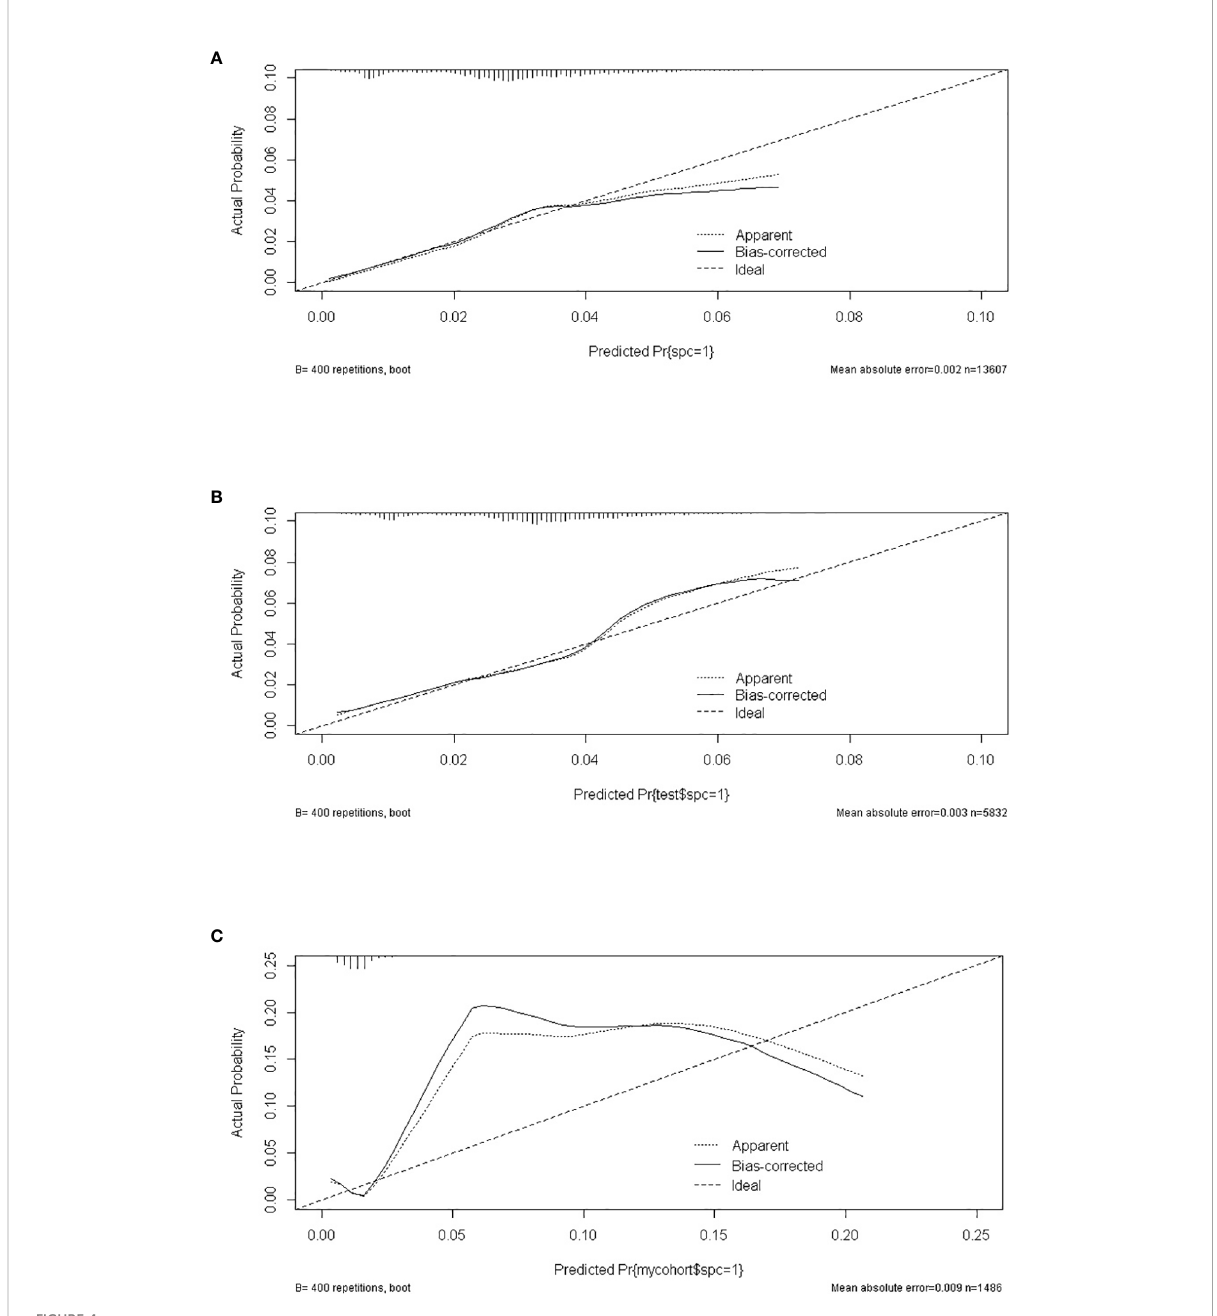
FIGURE 4 The calibrate curves of SPM risk prediction nomogram. (A) trainset; (B) testset; (C) external test